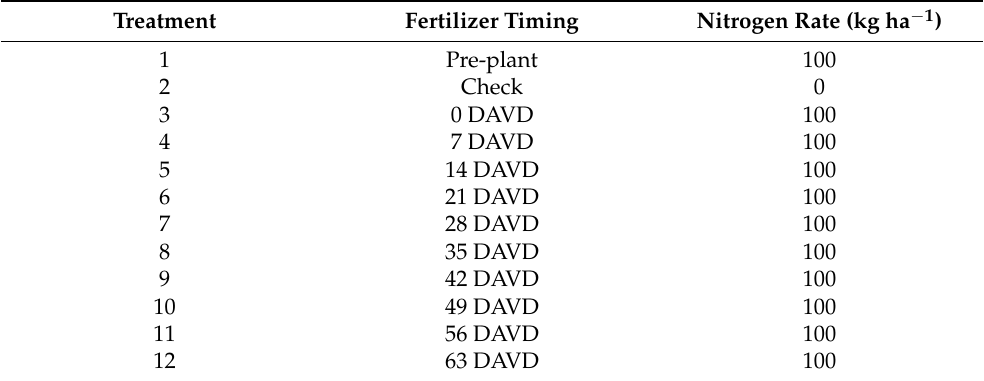
Table 3. Treatment structure implemented at all locations. Nitrogen application timings of the in-season treatments based on the growing degree days after visual N deficiency (DAVD) between the non-fertilized check and the pre-plant N treatment.